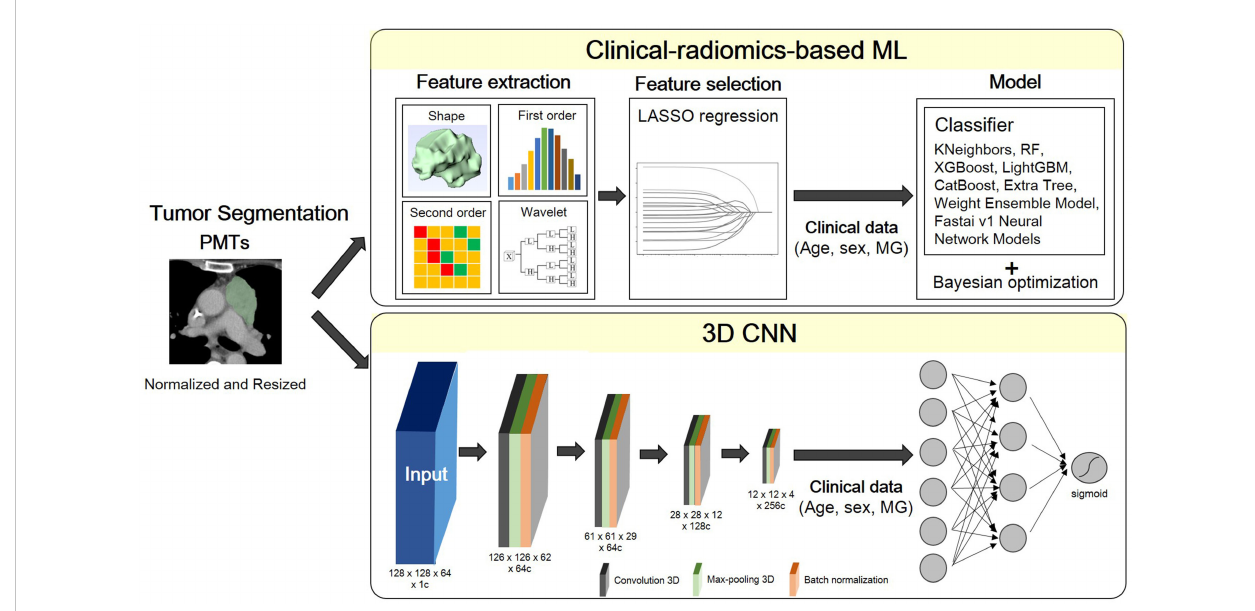
FIGURE 2 Flowchart of the proposed scheme. PMT, prevascular tumor; LASSO, least absolute shrinkage and selection operator; MG, myasthenia gravis; RF, random forest; XGBoost, extreme gradient boosting; LightGBM, light gradient boosting